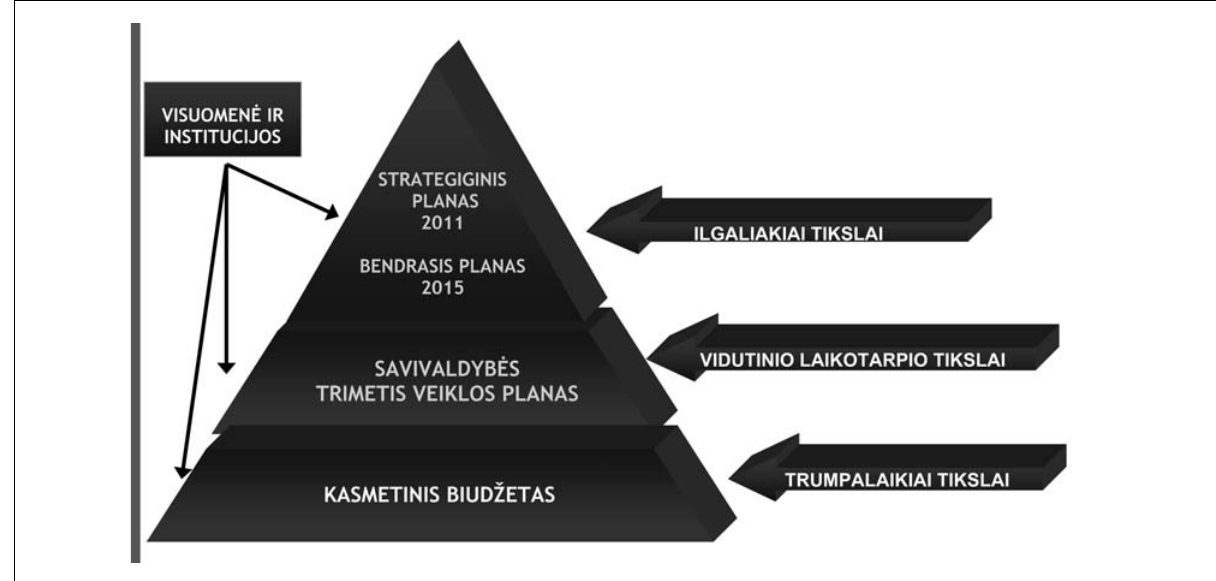
Fig 2. Master plan within the integrated system of plans and programmes of Vilnius Municipality, approved in